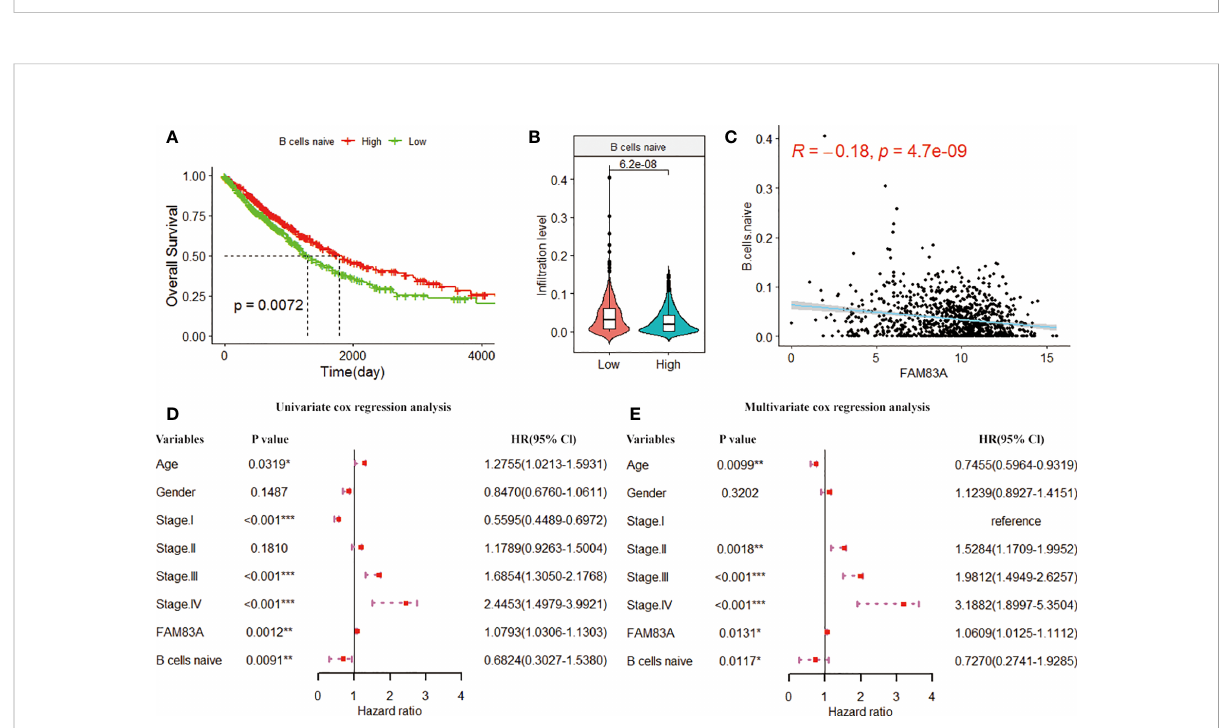
FIGURE 7 The K-M curve of (A) naive B cells in fi ltration level and overall survival. The green and red curves represent the sample group with low expression and high in fi ltration level, respectively. (B) Violin plot of naive B cell in fi ltration in FAM83A high and low expression groups. (C) Scatter plot of the correlation between the in fi ltration level of naive B cells and the FAM83A expression. (D) Univariate cox forest plots related to the prognosis of clinical factors. (E) . Multivariate cox forest plots related to the prognosis of clinical factors. (*p<0.05, **p<0.01,